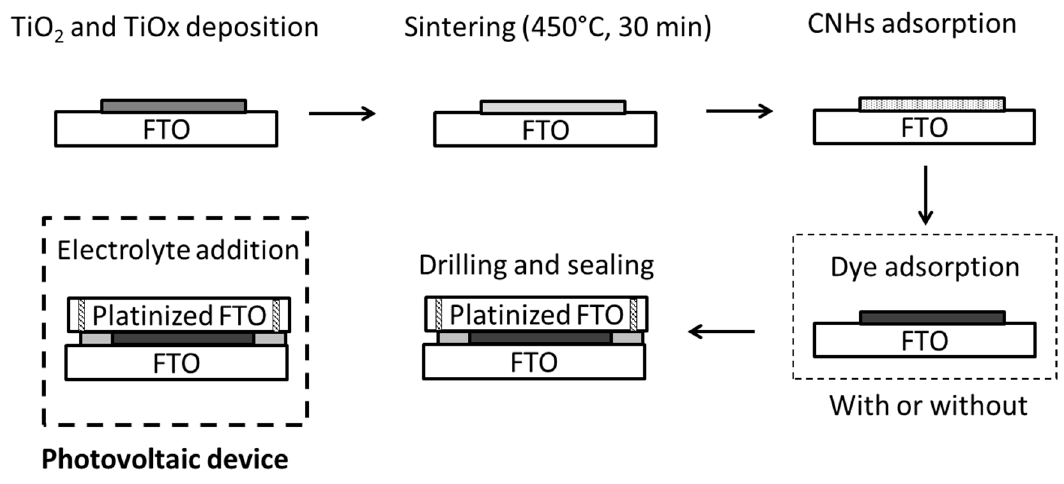
Figure 12. Preparation of DSSCs having dye-CNHs as additives.